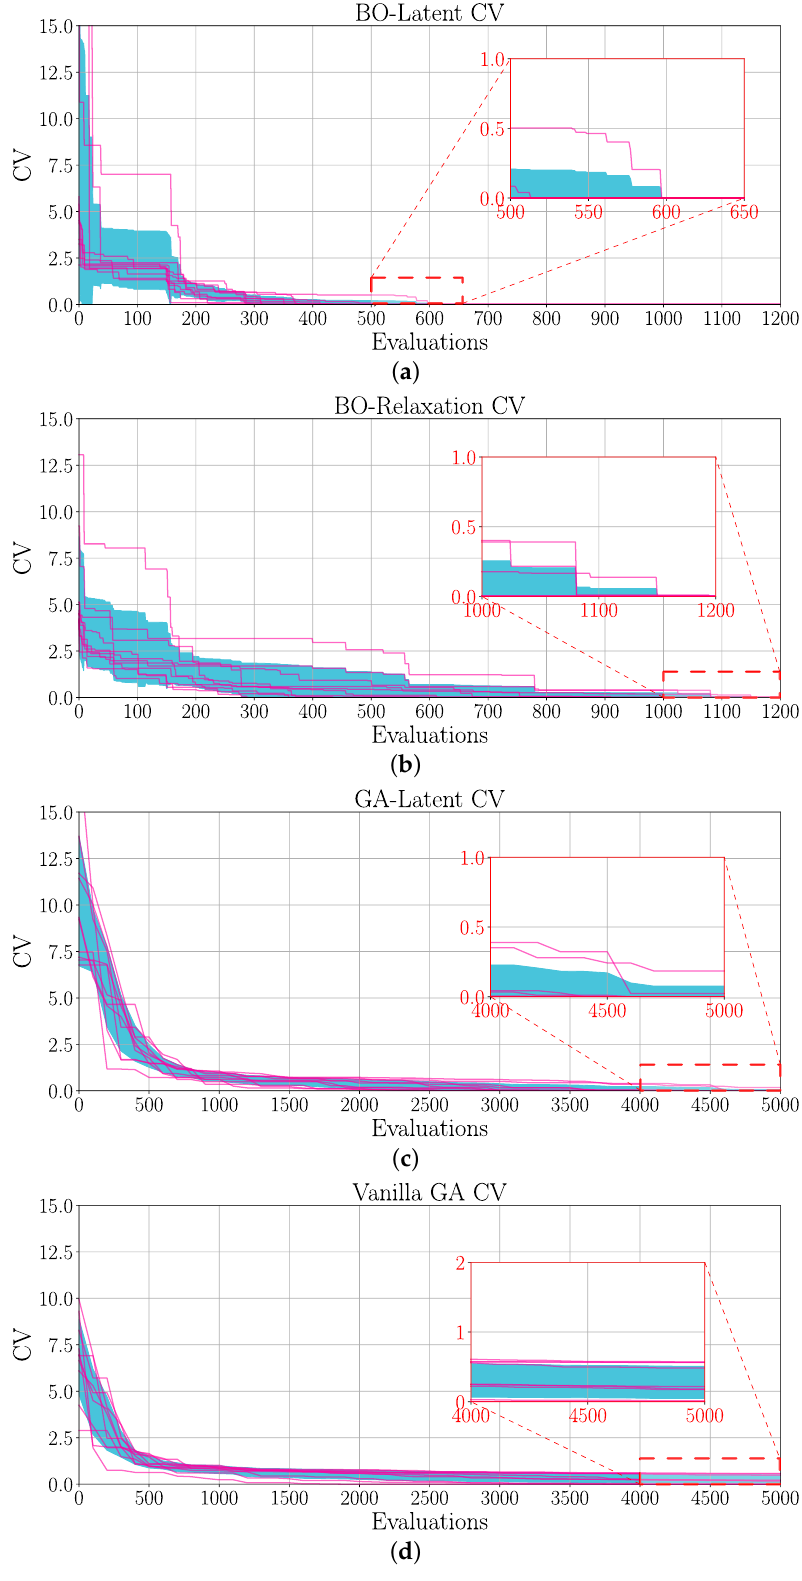
Figure 7. The LNA’s CV for the discussed formulations. The blue area indicates the confidence region of ± std, while the purple lines are the curves of each repetition. ( a ) BO-Latent. ( b ) BO-rounding. ( c ) GA-Latent. ( d )